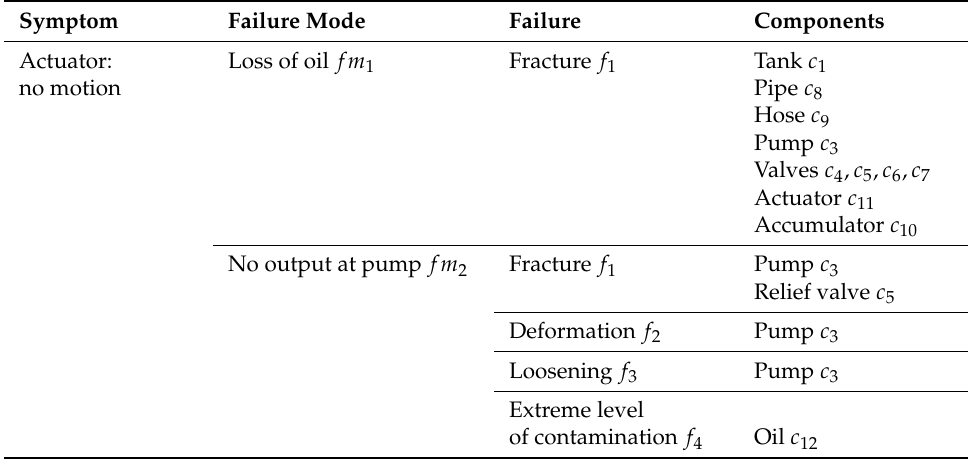
Table 1. Functional failure ( f f 1 ): System is unable to perform intended function. Symptom Failure